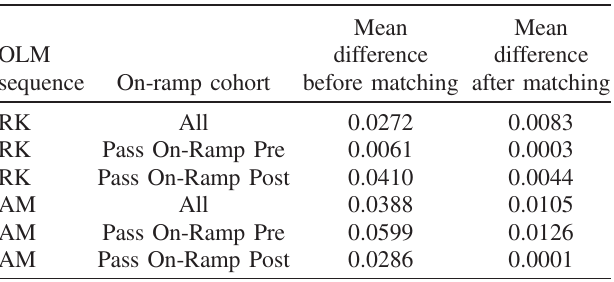
TABLE II. The mean difference in propensity scores between the listed 2017 and 2018 on-ramp cohorts both before and after propensity score matching was carried out. All students in these samples are in the 0 – 1 BA